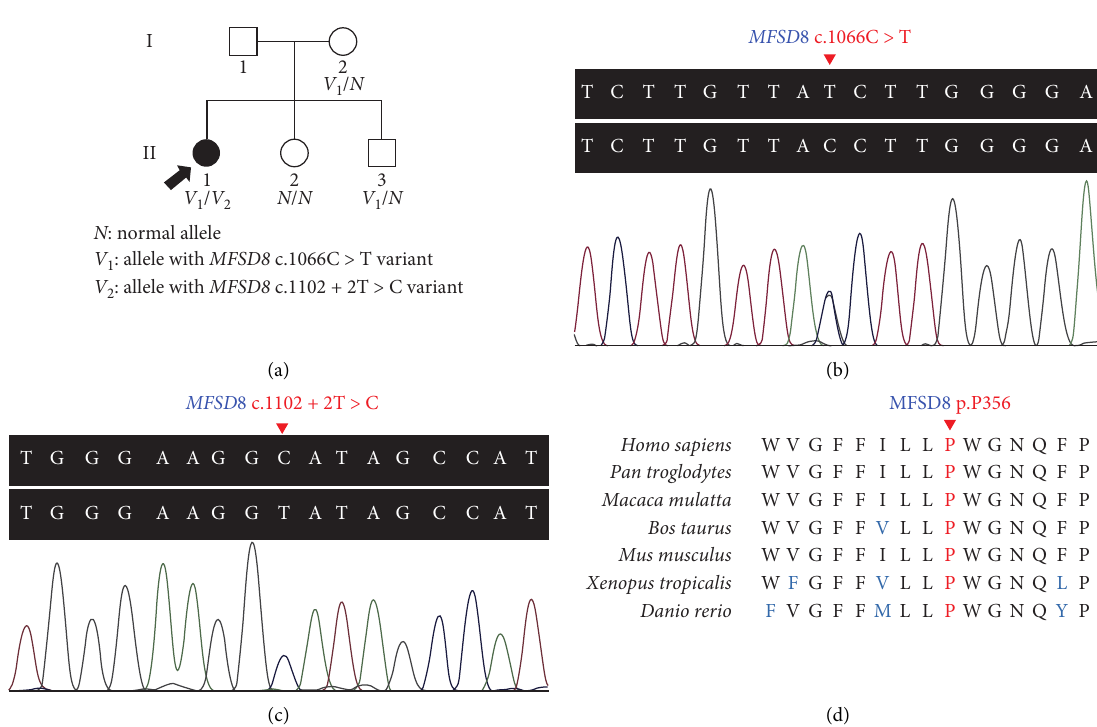
Figure 1: Compound heterozygous MFSD8 gene variants identified in a macular dystrophy family. (a) A Chinese macular dystrophy pedigree. Squares and circles represent males and females, respectively. The fully shaded circle represents the female patient. The arrow indicates the proband. (b) Sanger sequencing validated the heterozygous c.1066C > Tvariant in the proband. (c) Sanger sequencing validated the heterozygous c.1102+2T > C variant in the proband. (d) Alignment of MFSD8 proteins in various organisms. The proline residue at position 356 of MFSD8 protein is highly conservative across seven different species. MFSD8, major facilitator superfamily domain containing